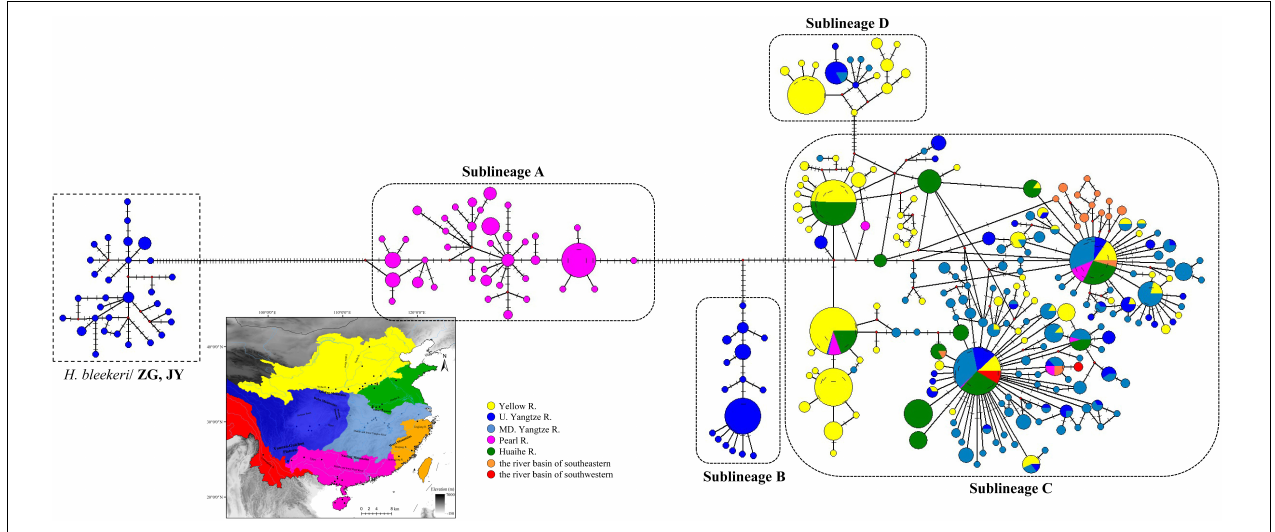
FIGURE 2 | Median-joining haplotype network based on 1,070 cytb sequences of H. leucisculus (see Supplementary File 1 ). The size of the circles represents haplotype frequency. Each connecting line represents a single nucleotide substitution, and each little short line represents a mutated position. Different river systems were represented in different colors, consistent with the colors of